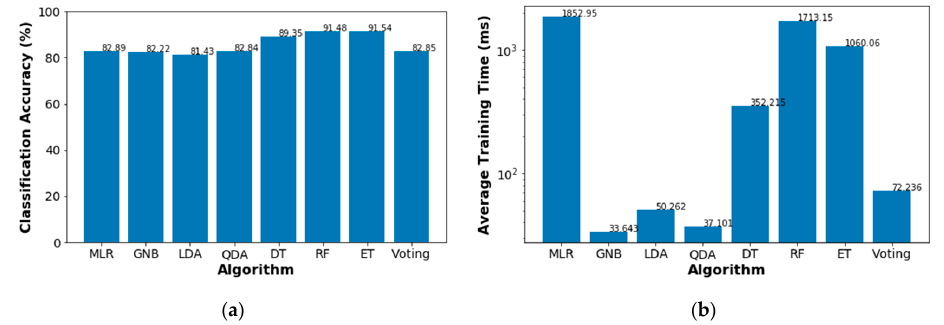
Figure 8. Classifiers performance comparison: ( a ) average classification accuracy; ( b ) average training time.